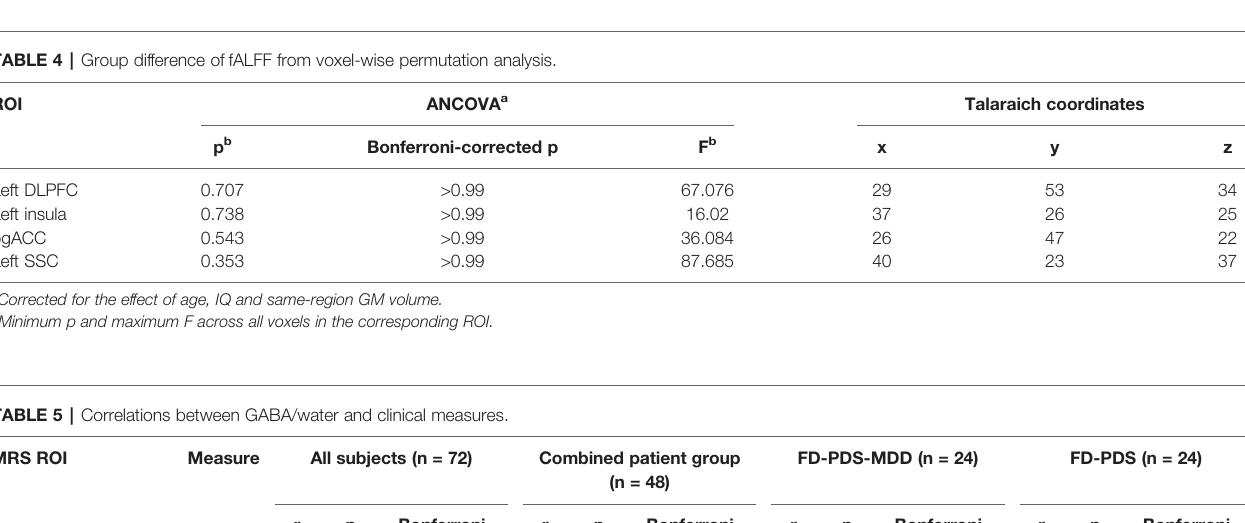
Left Insula FGISQ − 0.05 0.66 HAMA − 0.11 0.35 >0.99 Anterior Cingulate